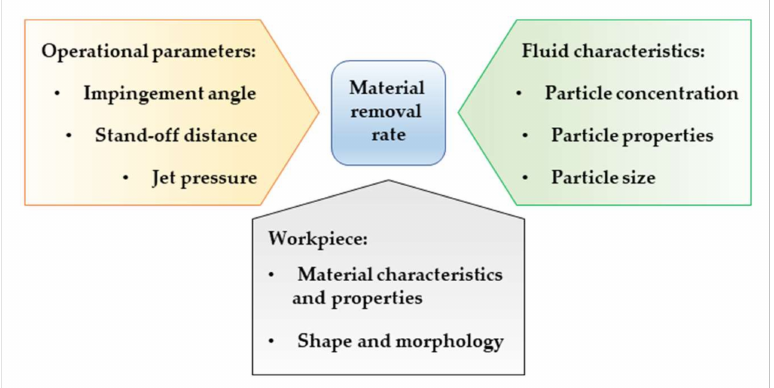
Figure 2. Main factors affecting the material removal rate in the FJP